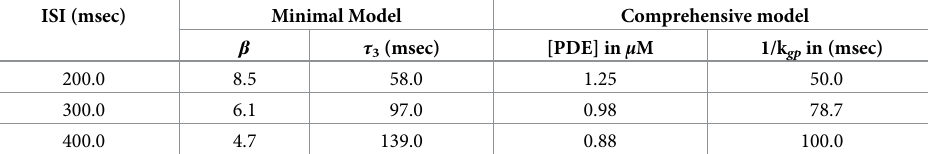
Table 2. Model parameters for different conditional responses of the Purkinje